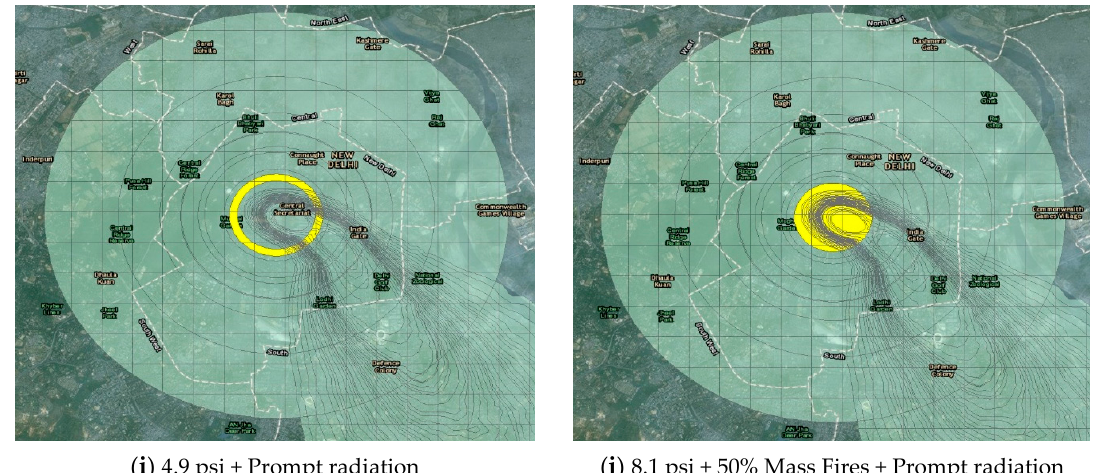
Figure 4. Effect circles and their associated impacts for a single 25 kt nuclear weapon.